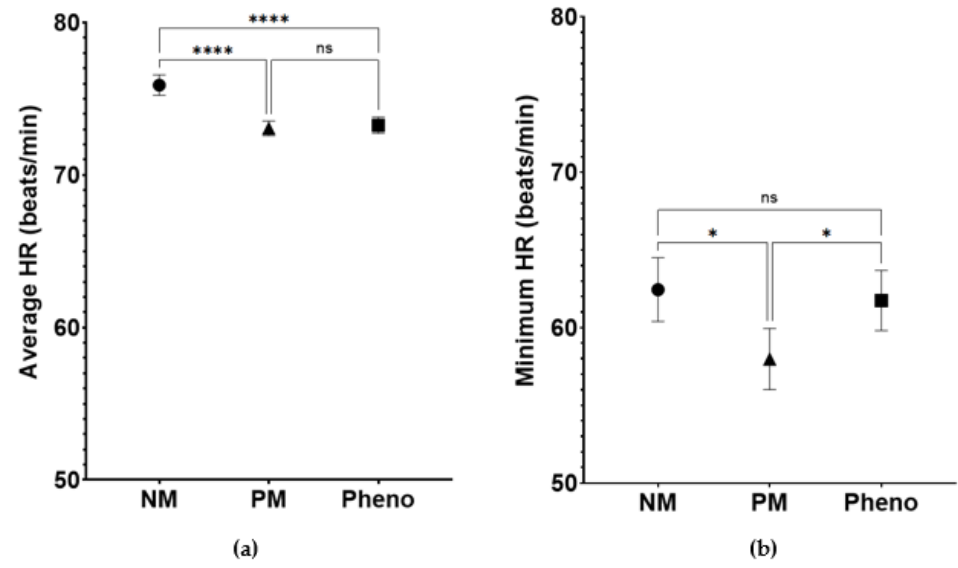
Figure 4. Ambulatory measurements of heart rate for all patients taken throughout the study obser-